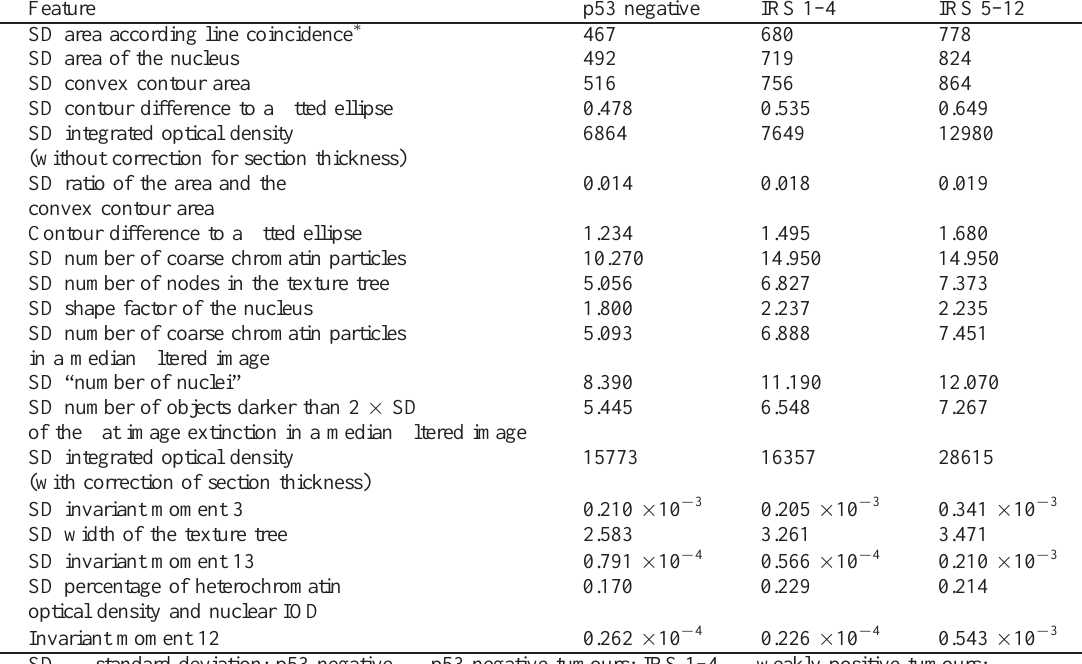
Table 7 Significance in different features of tumours with different p53 expression with a G2M-fraction greater than 5% ( p < 0 .